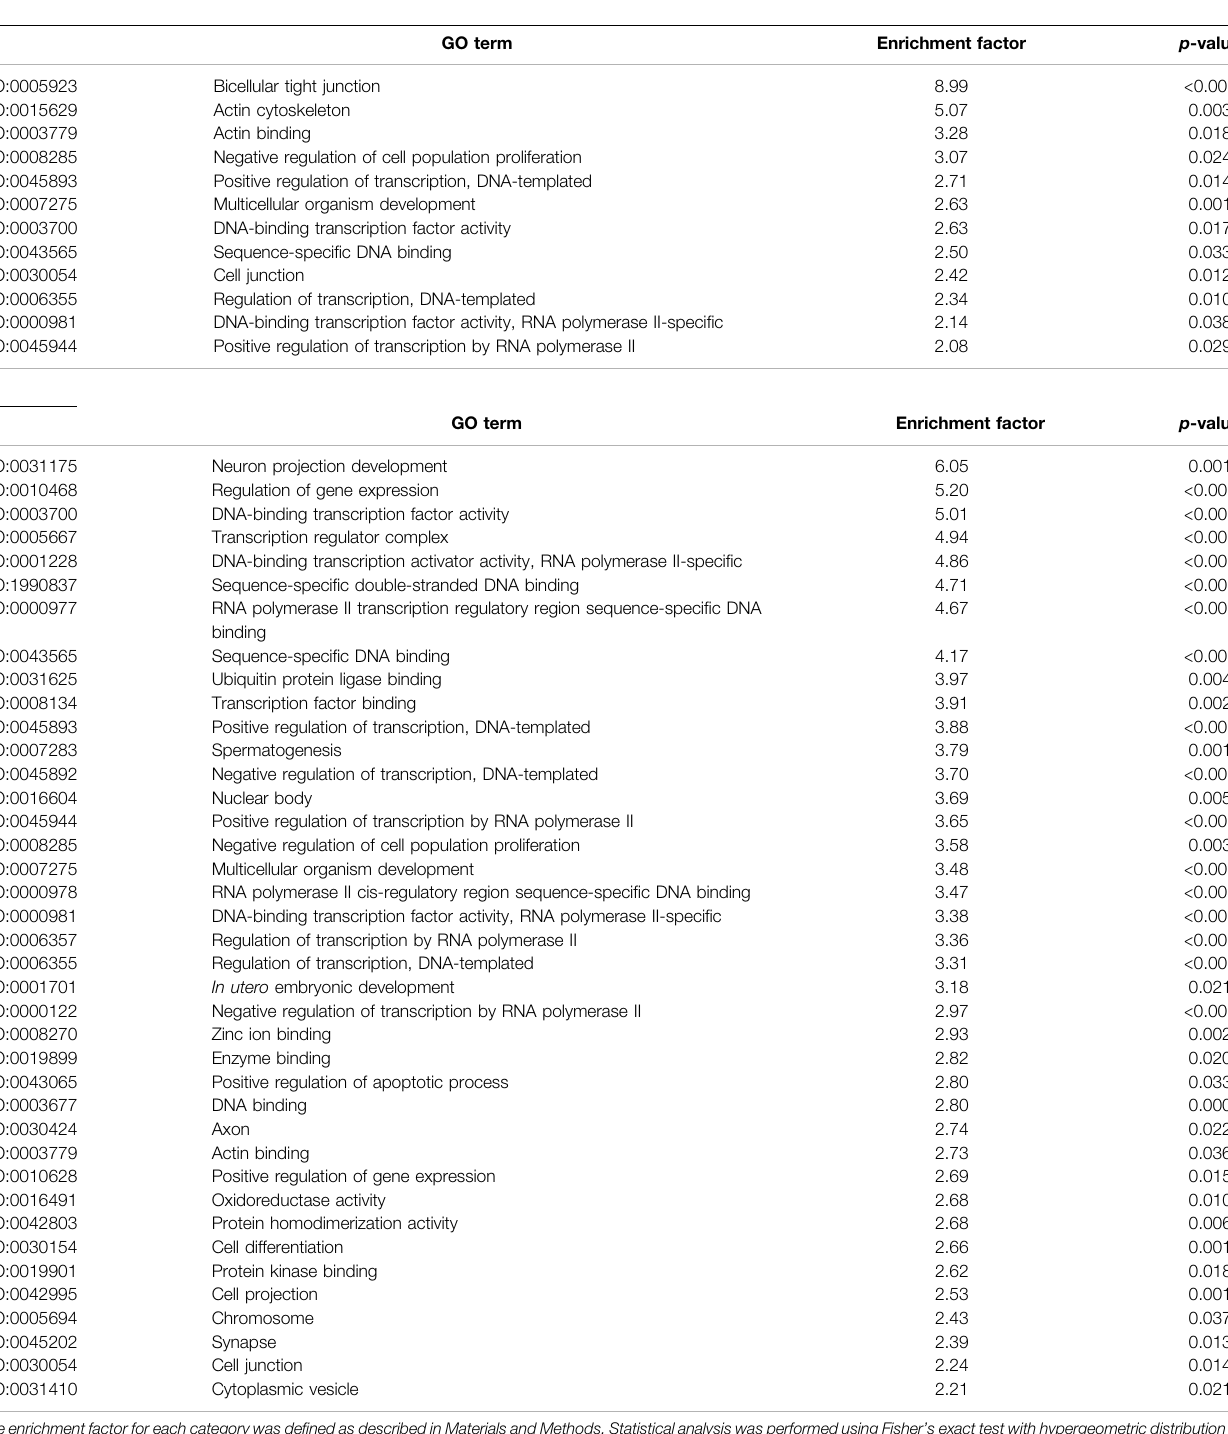
TABLE 3 | GO terms enriched in the genes that showed differential expression accompanied by altered DNA methylation in male (A) and female (B) offspring in the TiO 2 -H